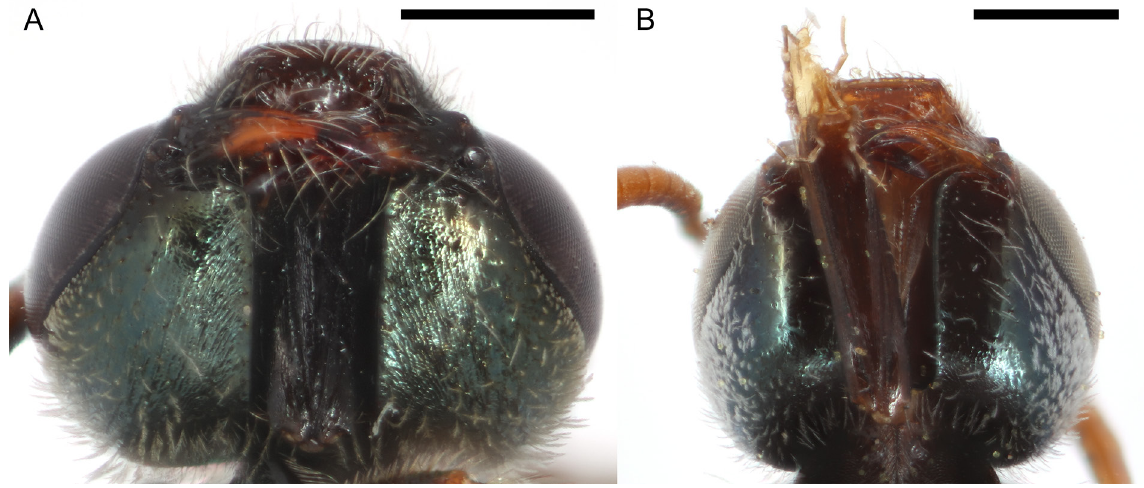
Fig. 102. Postgena. A . Lasioglossum ( D. ) pictum (Crawford, 1902), ♀, dull and lineate. B . L. ( D. ) lilianae sp. nov., ♀, shiny. Scale bars: 0.5